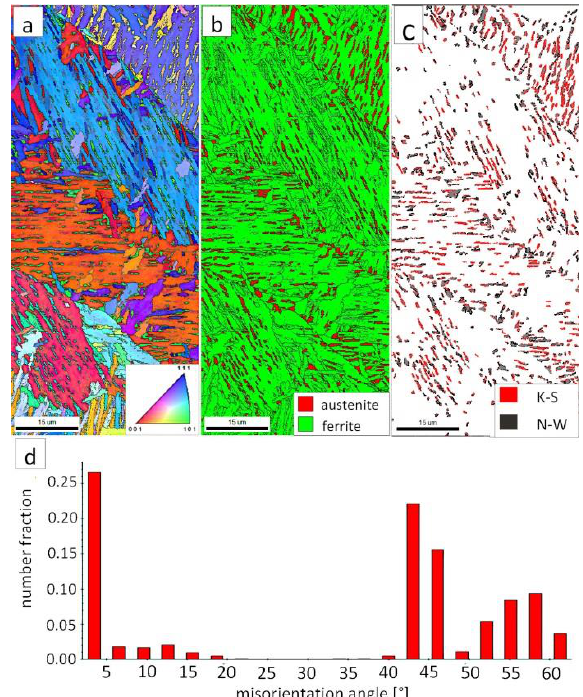
Table 4. Orientation relationships between ferrite and austenite [24,25] along with the range of misorientation angles used in the EBSD investigations.